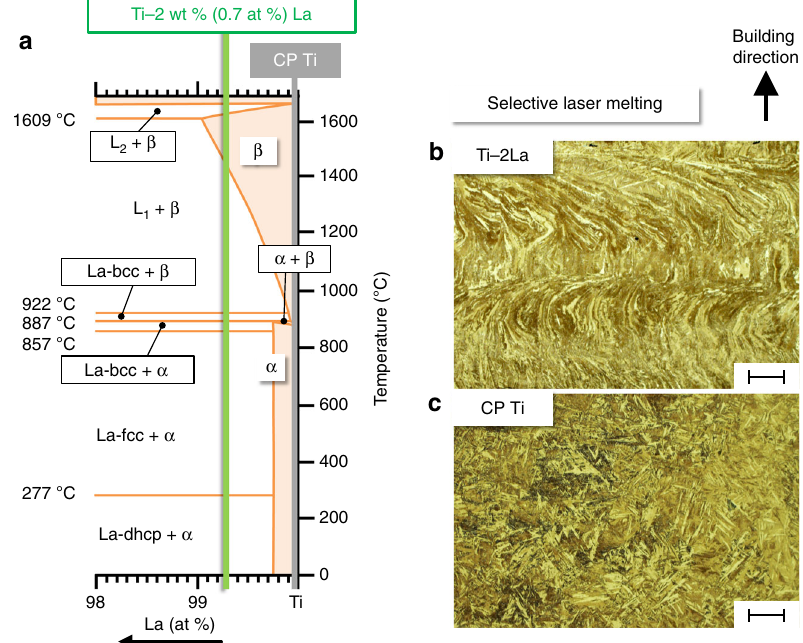
Fig. 1 Additive manufacturing of the Ti – La system. The approach of selecting a composition Ti-2wt.% La permits to explore an uncommon path of α formation in titanium alloys, by altering the regular Burgers-related β → α transformation. a Portion of the Ti – La phase diagram adapted from 29,50 , indicating the compositions used for selective laser melting. b , c Overview of the as-built microstructures for these compositions, namely commercially pure titanium grade 1 (CP Ti) taken as reference, and the Ti-2wt.% La alloy (Ti-2La), respectively. Scale bars, 100 μ